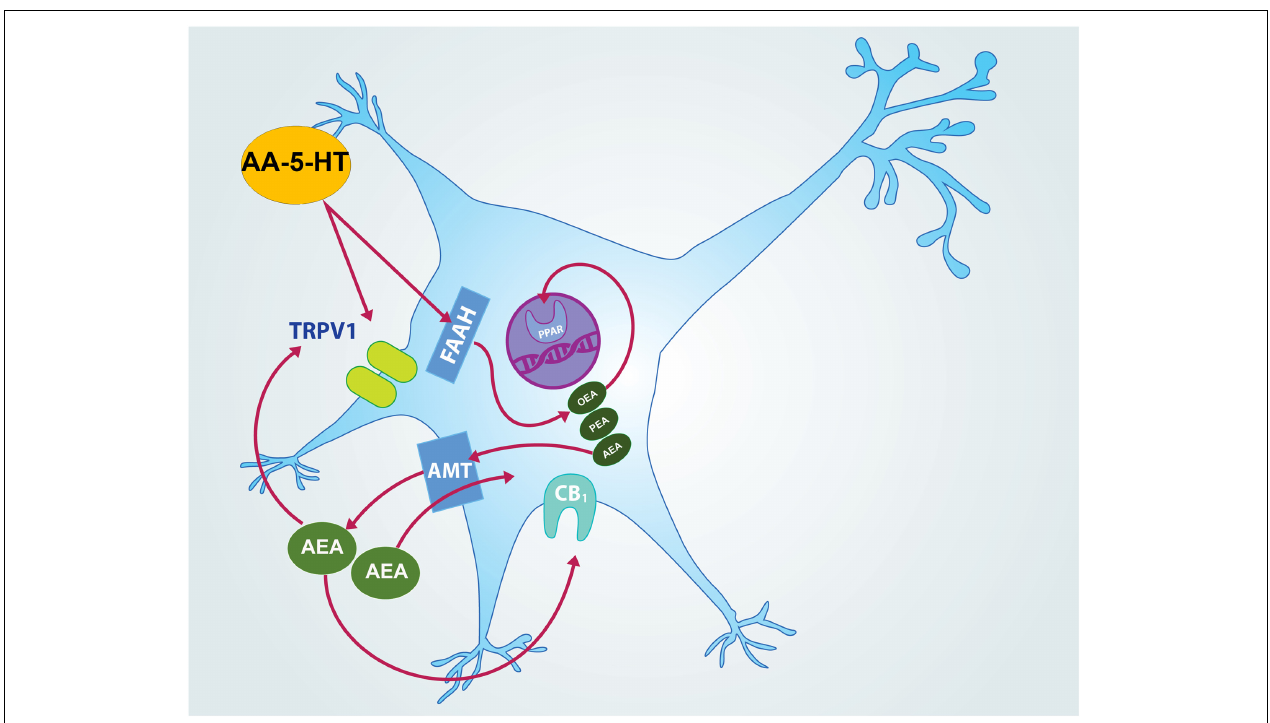
FIGURE 13 | Hypothetical molecular mechanism of action of AA-5-HT in sleep promotion. In this empirical proposal, AA-5-HT inhibits fatty acid amide hydrolase (FAAH) which in turn increases levels of oleoylethanolamide (OEA) and palmitoylethanolamide (PEA) as well as anandamide (AEA). Whereas OEA binds to PPAR α in nucleus and promotes waking, AEA is able to diffuse across the cellular membrane by anandamide membrane transporter (AMT) to bind either CB 1 cannabinoid receptor or TRPV1. AA-5-HT can also antagonize AEA action at TRPV1. While activation of CB 1 cannabinoid receptor has been linked with sleep generation, further evidence is needed to determine whether activation or inhibition of TRPV1 would modulate